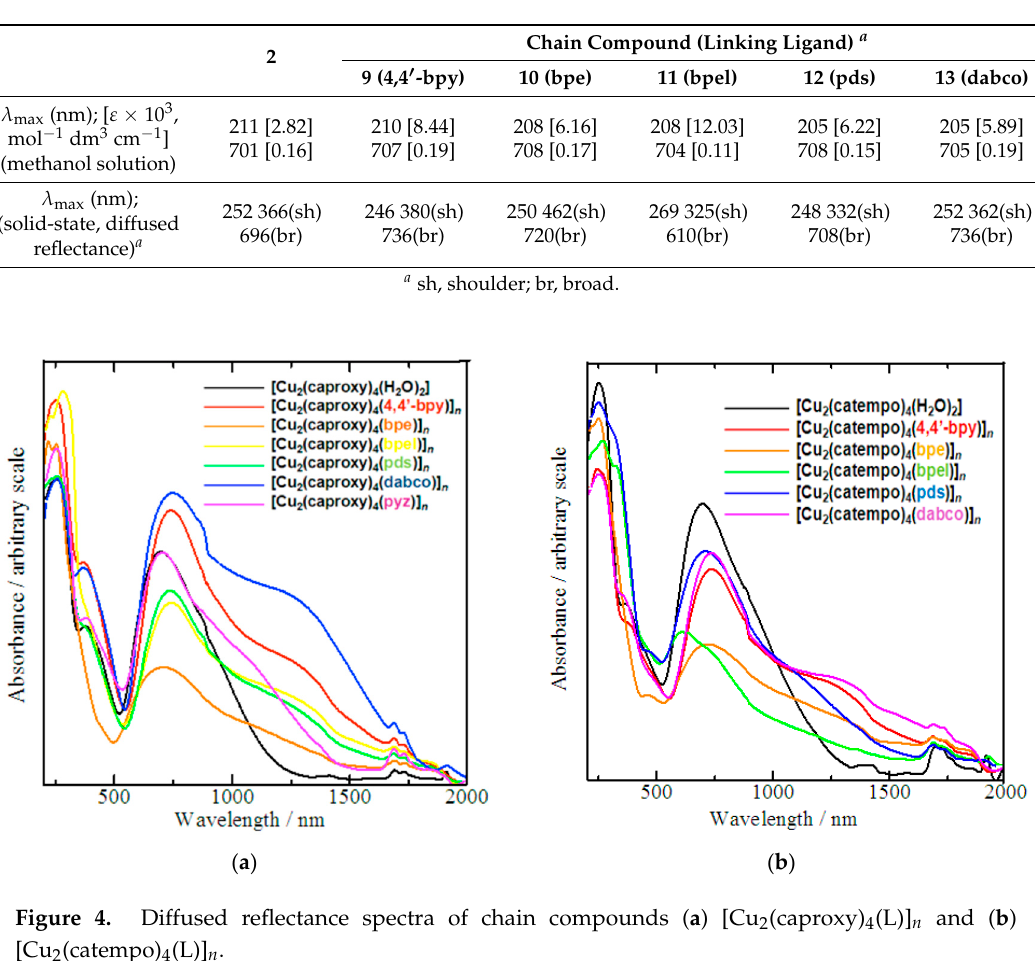
Table 4. Electronic spectral data of [Cu 2 (catempo) 4 (H 2 O) 2 ] ( 2 ) and chain compounds [Cu 2 (catempo) 4 (L)] n L = 4,4 (cid:48) -bpy ( 9 ), bpe ( 10 ), bpel ( 11 ), pds ( 12 ), and dabco ( 13 ).